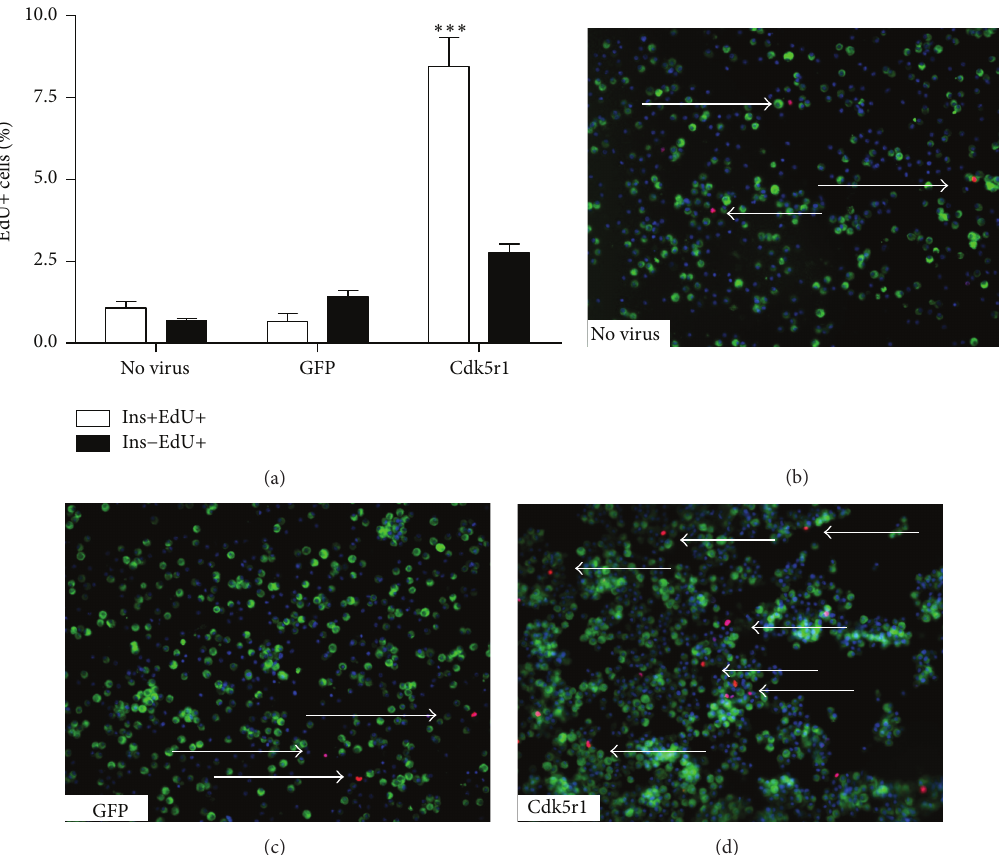
Figure 4: Overexpression of Cdk5r1 is sufficient to induce 𝛽 -cell proliferation. (a) Percentage of BrdU+Insulin+ islet cells cultured with BrdU for 96 hours. (b) Representative image (40x magnification) of dispersed rat islets transduced with AdCMV-GFP labeled with BrdU. (c) Representative image (40x magnification) of dispersed rat islets transduced with AdCMV-Cdk5r1 labeled with BrdU. Arrows indicate BrdU+Insulin+ nuclei. DAPI is blue, insulin is green, and BrdU is red. Data represent the mean ± SEM of four independent experiments. ∗∗ 𝑝 ≤ 0.01 . p value represents the comparison between Cdk5r1- and GFP-treated